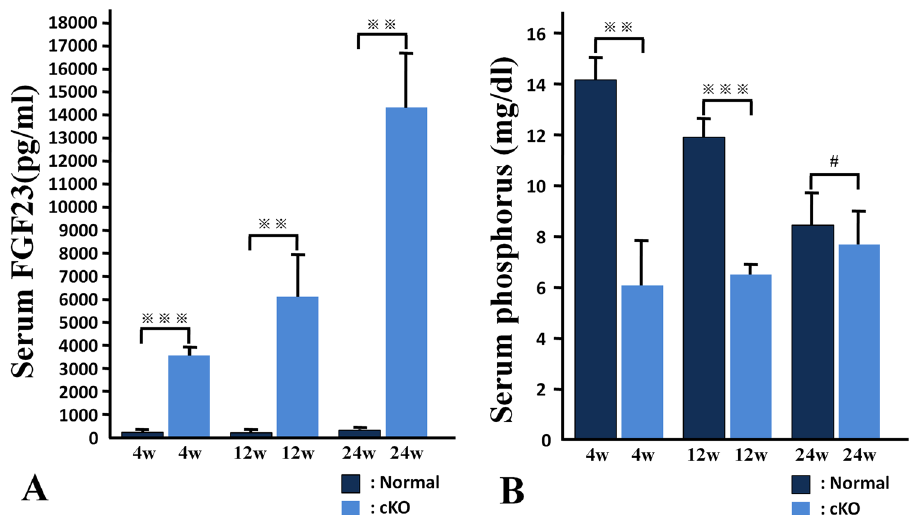
Figure 6. Serum FGF23 and phosphorus (Pi) levels. ** P < 0.05; *** P < 0.01; # P > 0.05. The serum FGF23 level was remarkably higher in the cKO mice than the normal mice at each of the time points ( A ). The serum phosphorus levels in the 4-week-old and 12-week-old cKO mice were significantly lower than in the age- matched normal mice. The serum phosphorus level in 24-week-old cKO mice was not statistically different from the normal mice ( B